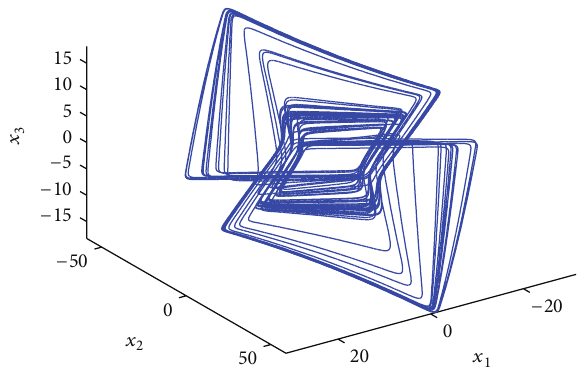
Figure 3: The phase portrait of (5) with 𝑓(𝑥) = tanh (𝑥) and 𝑘 = 60 .